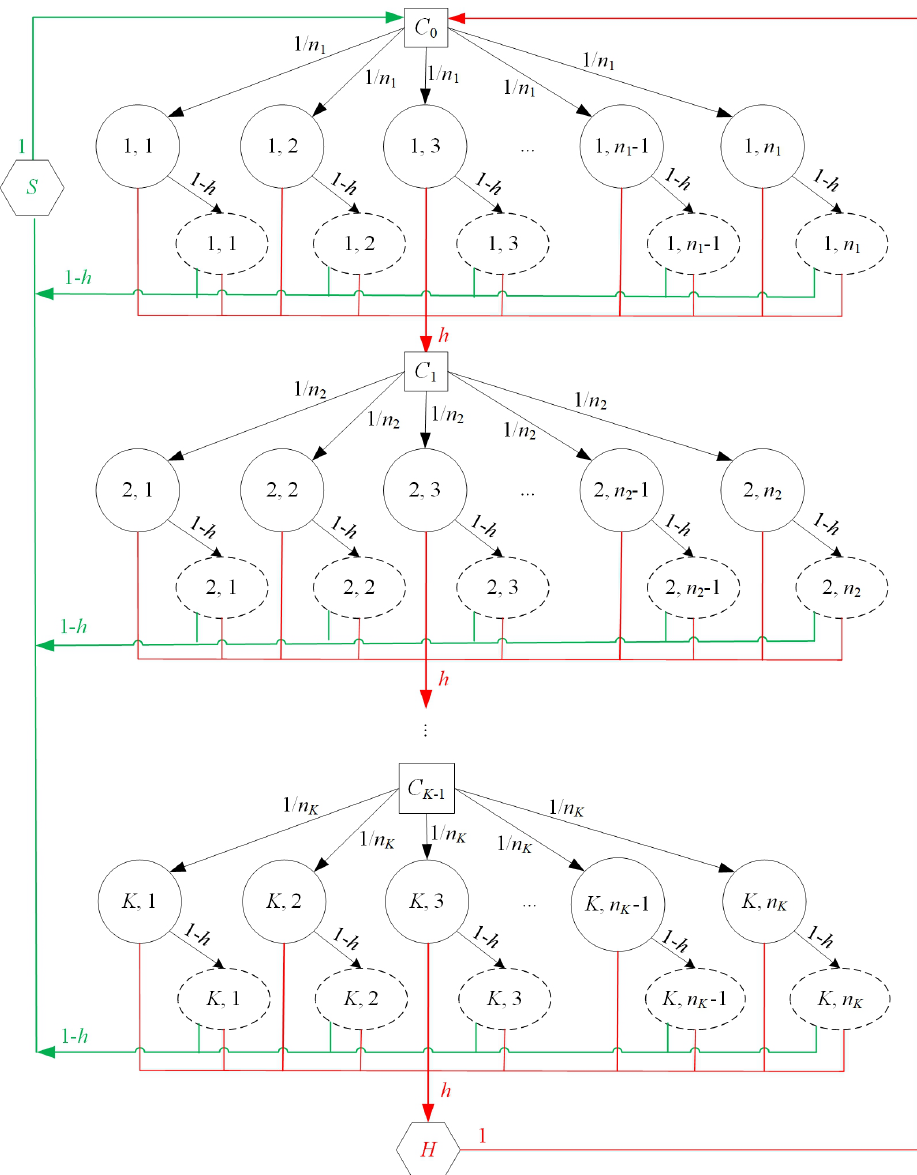
Figure 2. The state transition